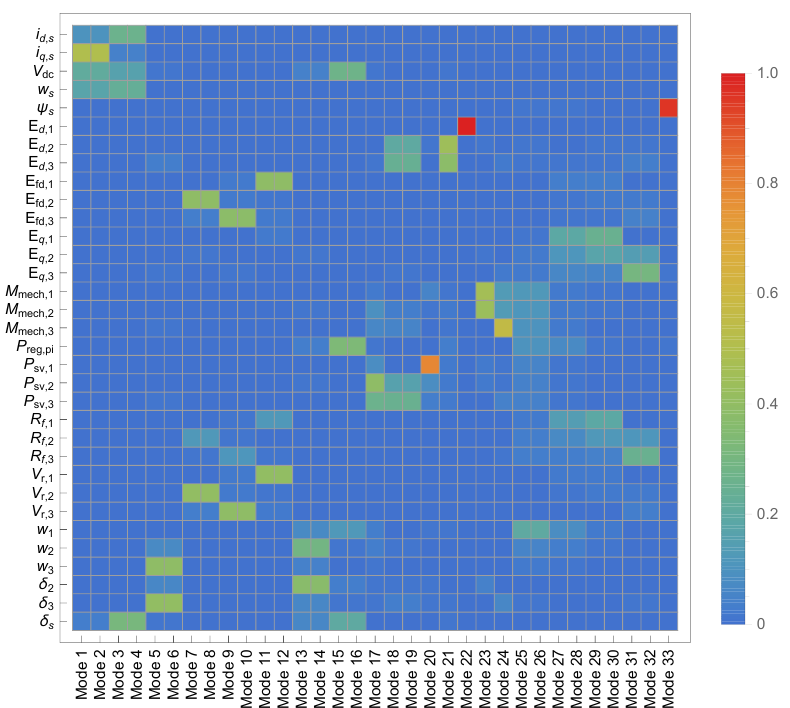
Figure A1. IEEE 9 bus: Matrix of Participation factors for the system with